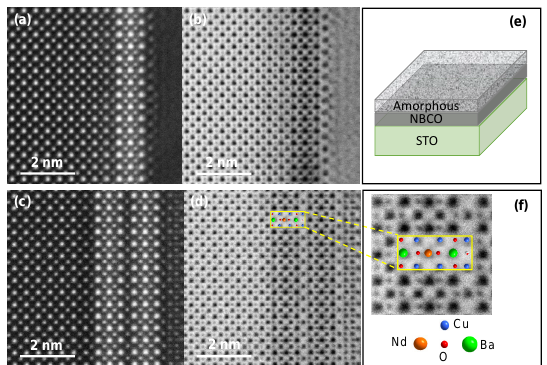
Figure 1. Scanning Transmission Electron Microscopy (STEM) images of epitaxial NBCO ultrathin films grown on STO with an overlay of the NBCO structural model. Images were obtained with the high-angle annular dark-field (HAADF) (panels a , c ) and annular bright-field (ABF) (panels b , d ) techniques. Panels ( a , b ) are for the 1 u.c. thick film, panels ( c , d ) for the 2 u.c. thick film. The details of atom position assignment is shown in panel ( f ). The scheme of the film growth structure is shown in panel ( e ).